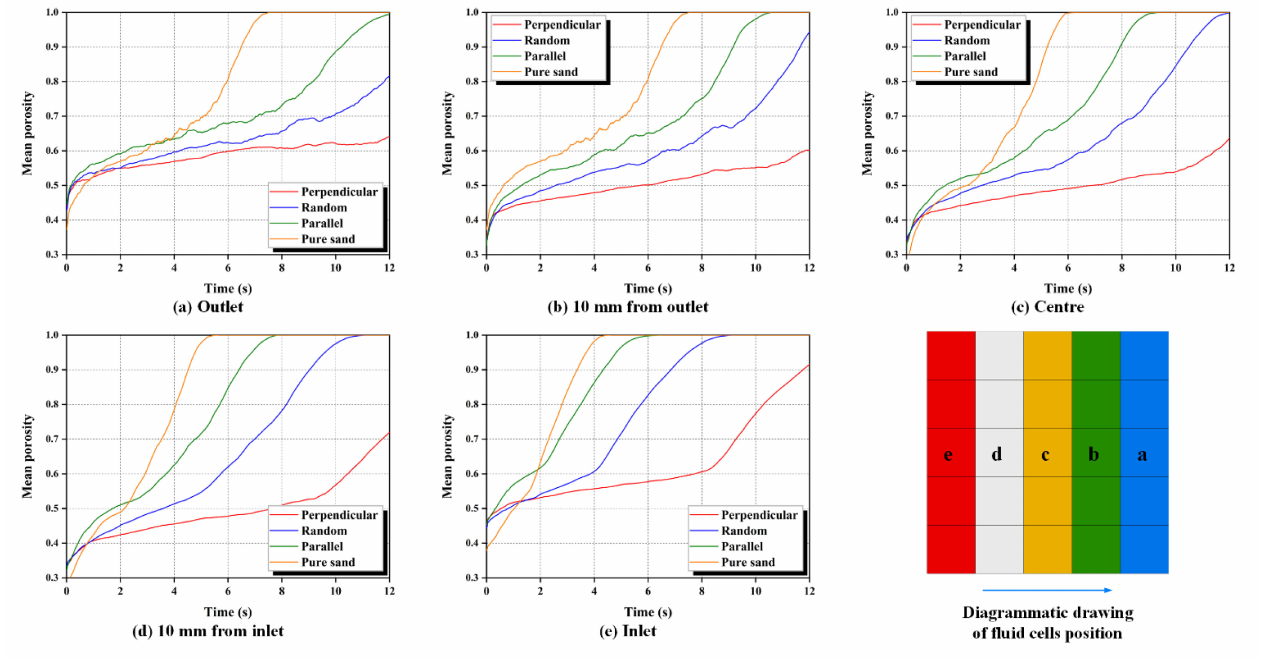
Figure 7. Evolution of the mean porosity of fluid